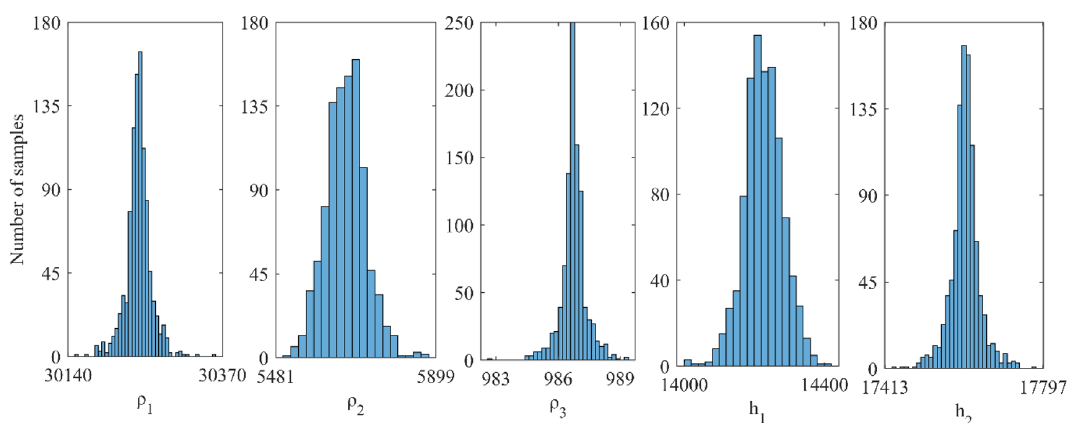
Figure 9. A number of samples versus vPSOGWO inverted layer parameters for three-layered noisy MT synthetic